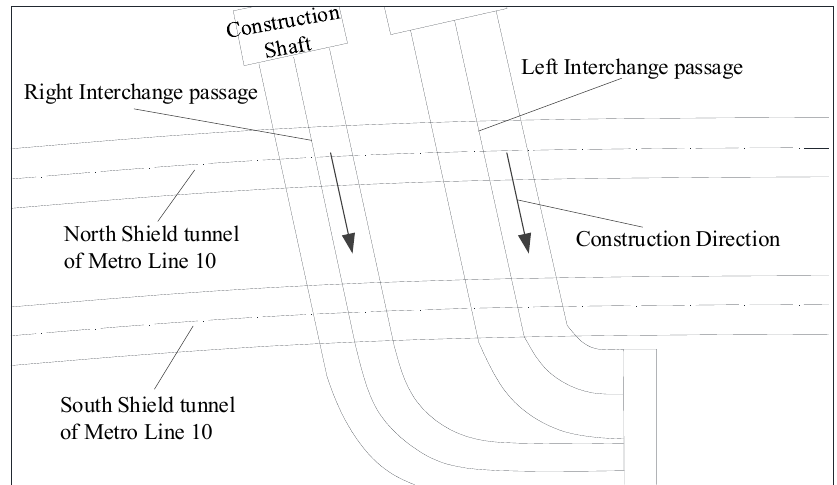
Figure 6. Layout of the interchange passages and Metro Line 10.